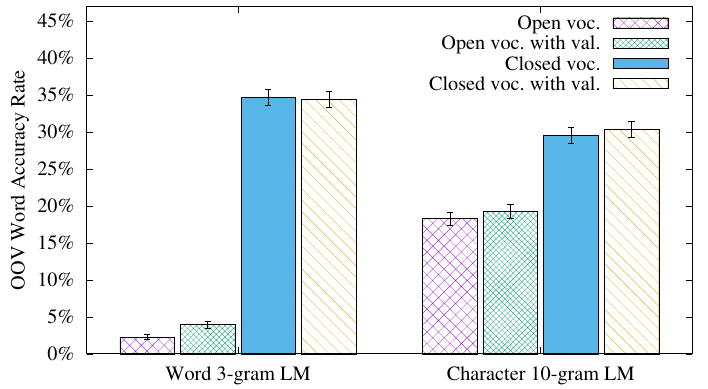
Figure 12. Recognition accuracy rate for OOV words by the best word-based HMM system and the best character-based HMM system with open and closed vocabulary, with and without using the validation samples for training the LM.